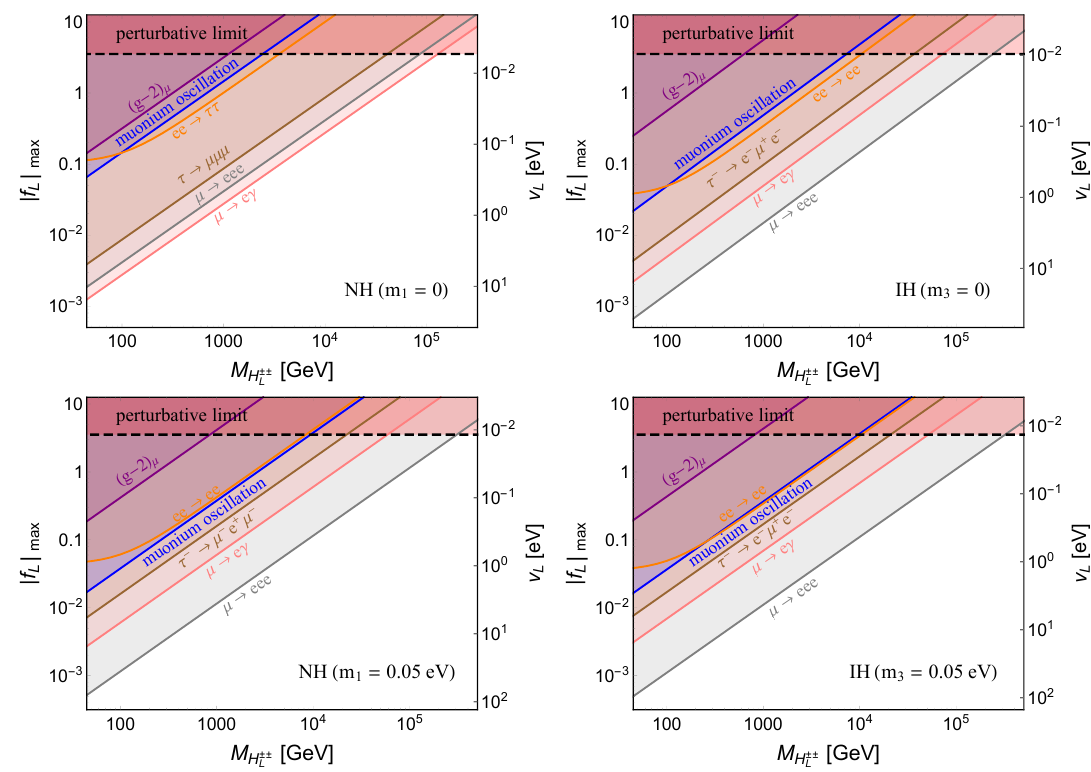
Figure 2 . LFV constraints on the doubly-charged scalar mass M coupling j f L j max in the type-II seesaw, for the NH (left) and IH (right) with the lightest neutrino mass m 0 = 0 (upper) or 0.05 eV (lower). All the shaded regions are excluded by either the low- energy LFV constraints on BR( ‘ (cid:11) ! ‘ (cid:12) ‘ (cid:13) ‘ (cid:14) ), BR( ‘ (cid:11) ! ‘ (cid:12) (cid:13) ) [70], anomalous muon g (cid:0) 2, muonium oscillation, or the LEP e + e (cid:0) ! ‘ + ‘ (cid:0) data [84]. More constraints can be found in table 2. The horizontal black line represents the perturbative limit of j f L j max <